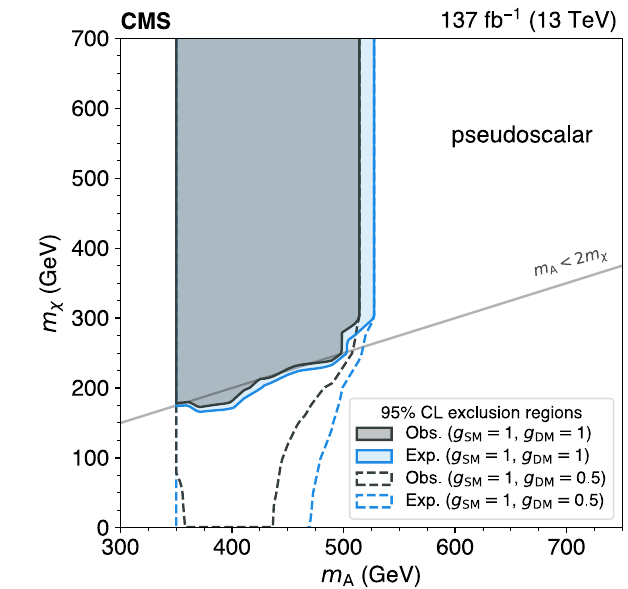
Fig. 9 Exclusion regions at 95% CL in the plane of m χ vs. m H (left) or m A (right). The outer lighter and inner darker solid curves show the expected and observed limits, respectively, assuming g SM = g DM = 1.